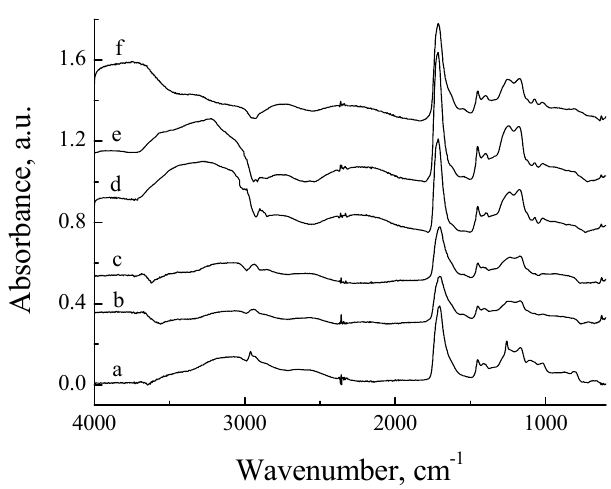
Figure 4. FTIR spectra for (a) PAH18 ; (b) PAH18 after absorption of 40 kGy and (c) 50 kGy; ( d ) PAH9 after absorption of 30 kGy, ( e ) 40 kGy, and ( f ) 50 kGy.